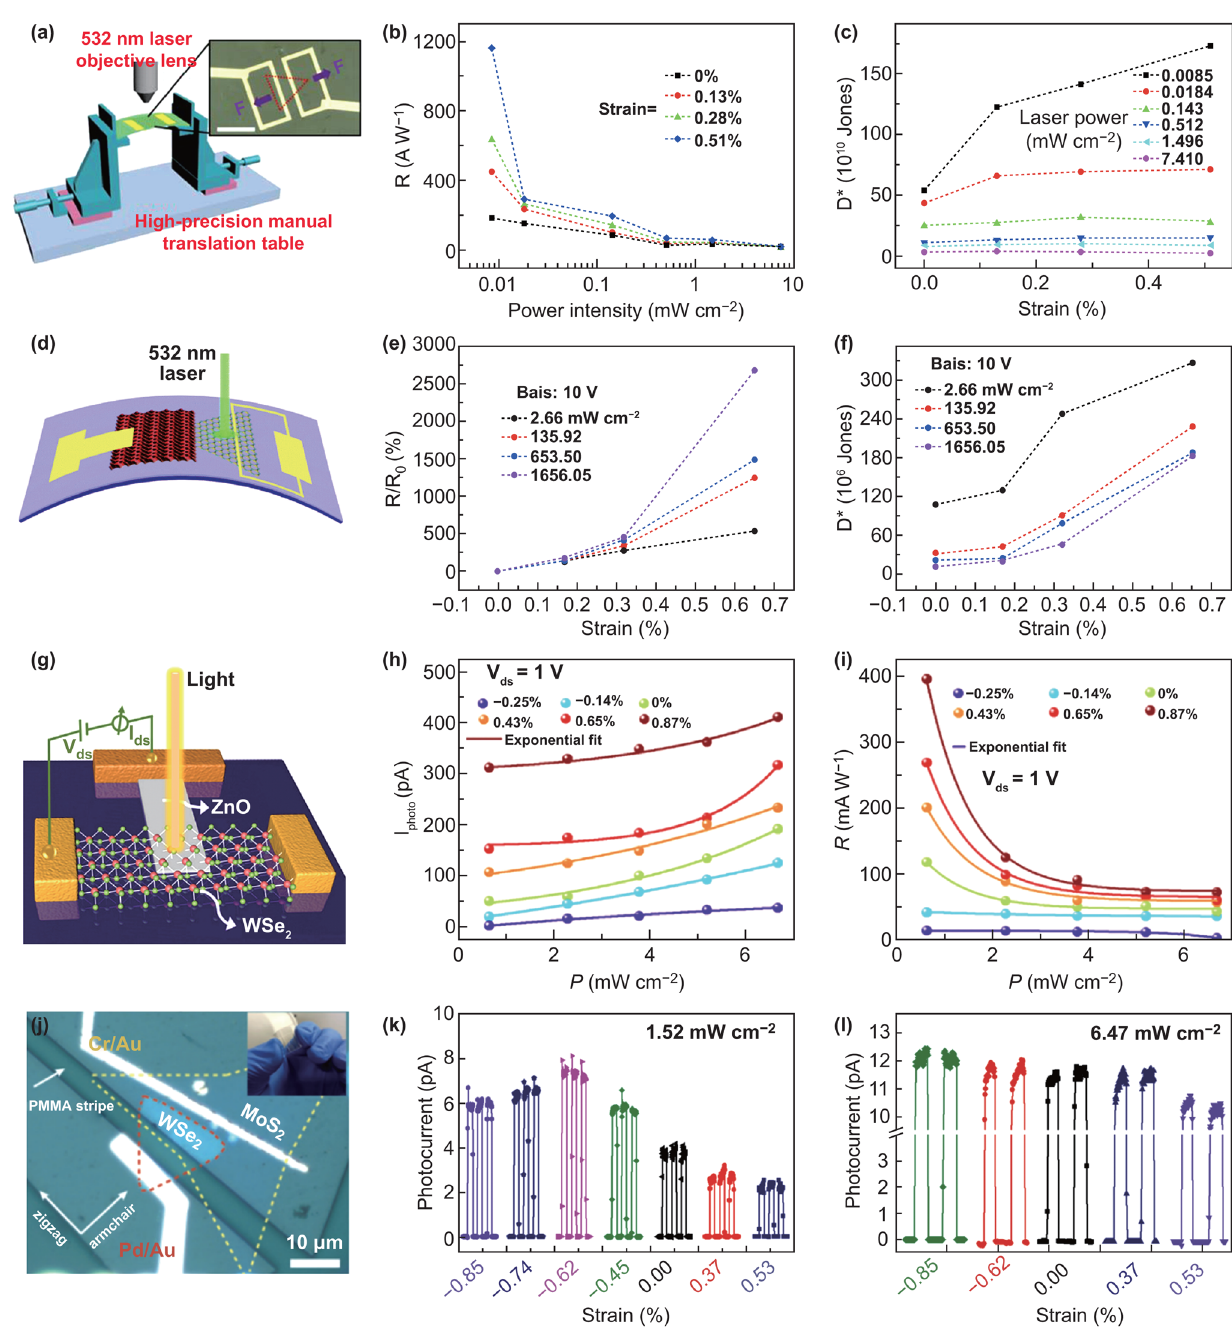
Fig. 16 Tuning the performance of photodetector by strain-induced piezoelectric effect. a Home-made high-precision table for loading strain. The optical image presents a MoS 2 device structure. Variations in value of b photoresponsivity and c detectivity at a bias of − 10 V under dif- ferent strains and various optical power intensities. Reproduced with permission [205]. Copyright 2018, IOP Publishing. d Schematic diagram of the flexible photodetector based on the p -CuO/ n -MoS 2 heterojunction. The strain dependence of e R / R 0 and f detectivity at different power densities at a bias of 10 V. Reproduced with permission [206]. Copyright 2017, Royal Society of Chemistry. g Schematic diagram of WSe 2 –ZnO photodetector on flexible PET substrate. h Strain-dependent photocurrent and i responsivity of the device for different illumination intensities under 1 V applied external bias. Reproduced with permission [207]. Copyright 2016, Elsevier. j Optical image of the fabricated MoS 2 /WSe 2 p – n photodiode device. Strain dependence of photocurrent in the device under the illumination of k 1.52 mW cm −2 and l 6.47 mW cm −2 light at zero applied bias. Reproduced with permission [208]. Copyright 2018,